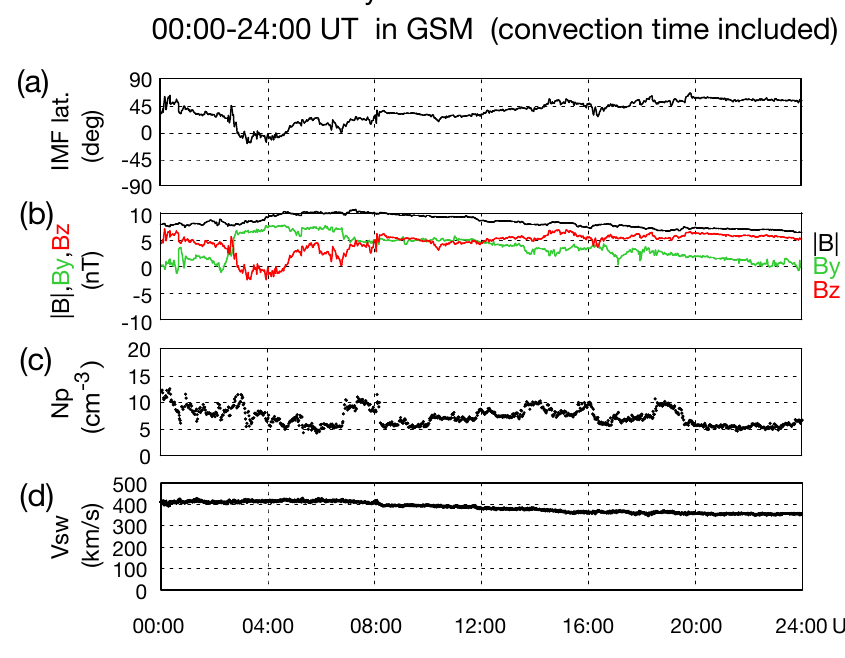
Fig. 7. Wind observation of the solar wind between 00:00–24:00UT on 9 February 1995, in the same format as Fig. 2. The time is shifted from the Wind location to the Earth’s